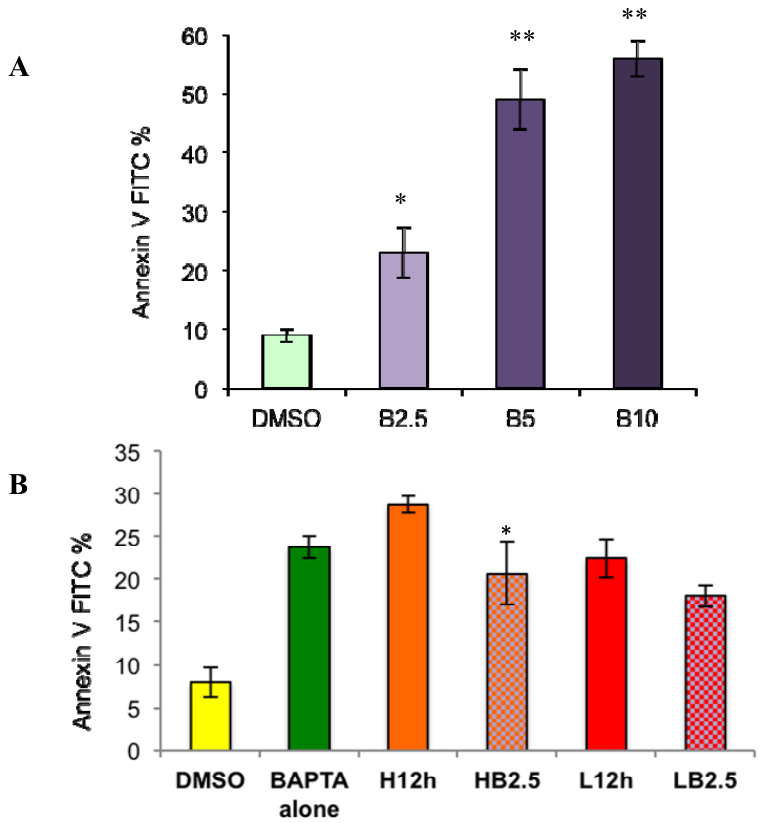
Figure 3. Effects of the external Ca 2+ chelator BAPTA on paclitaxel-induced